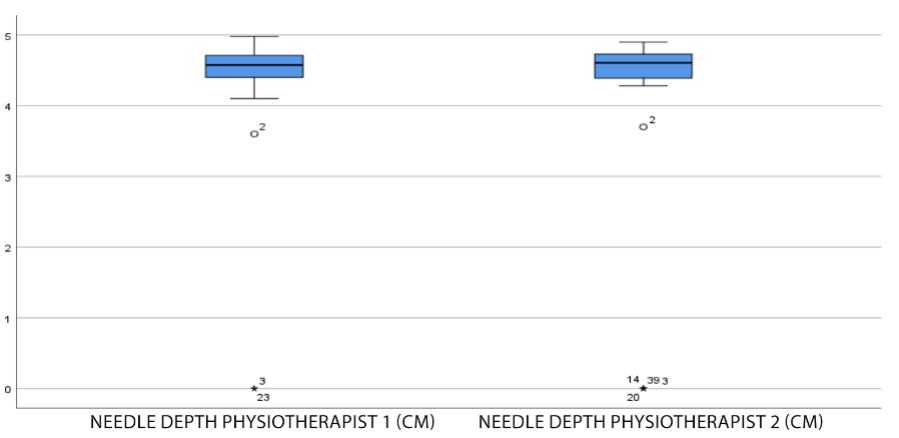
Figure 4. Box-and-whisker plot of the needle depth. The (*) outliers > 3 x IQR interquartile range